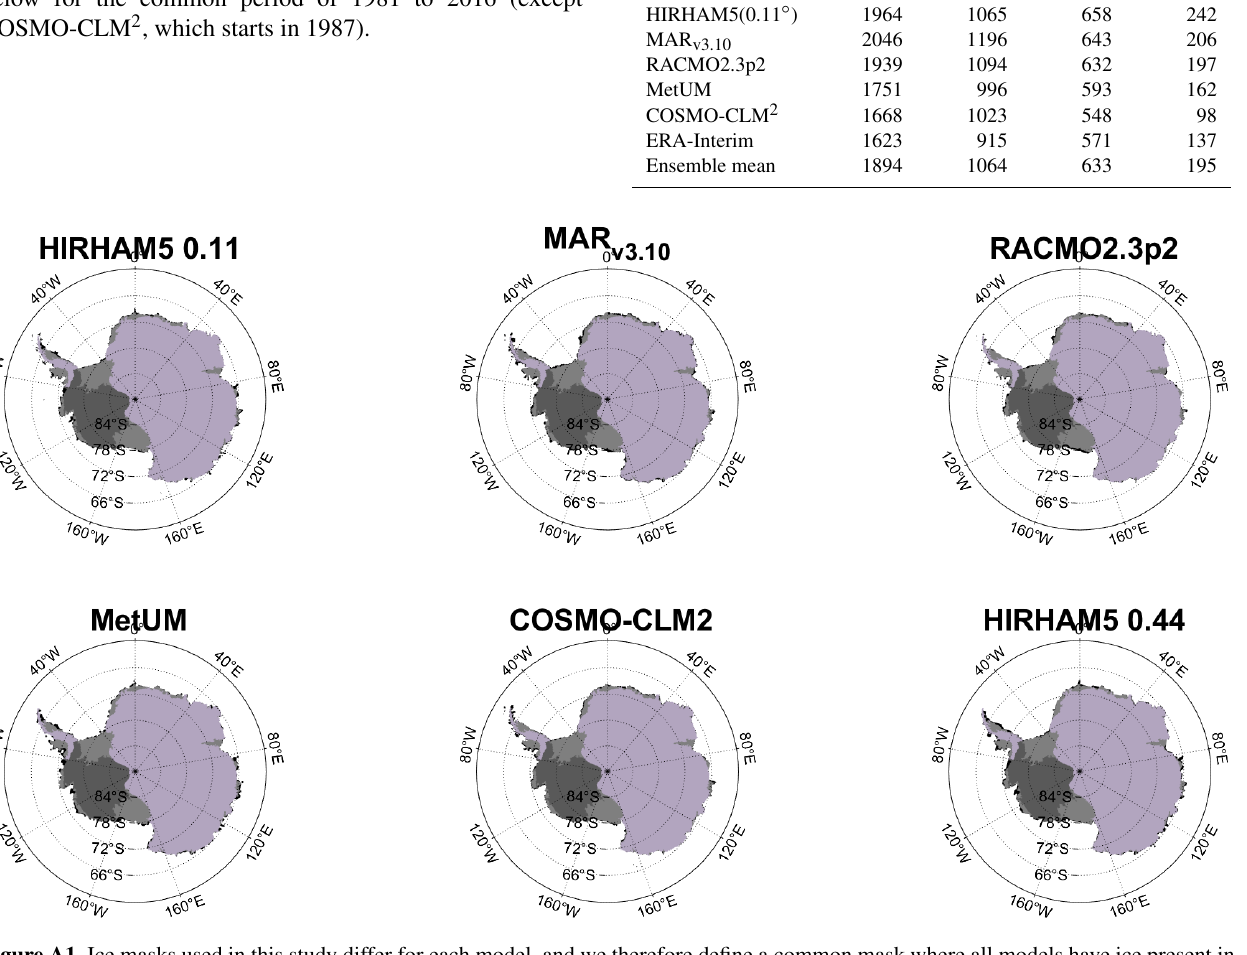
Figure A1. Ice masks used in this study differ for each model, and we therefore define a common mask where all models have ice present in the domain. The sub-figures show where the common mask and the individual model masks are identical; black indicates where individual models have ice that does not occur in the common mask. Most models do not distinguish the physiography between ice shelves and grounded land ice. Overlaid is the regional mask for the grounded ice sheet as calculated by Rignot et al. (2019). Purple shows the grounded ice in the East Antarctic (EAIS) and Antarctic Peninsula (AP) regions; dark grey is the grounded West Antarctic (WAIS) ice sheet. Floating ice shelves within the common mask are shown in light grey.